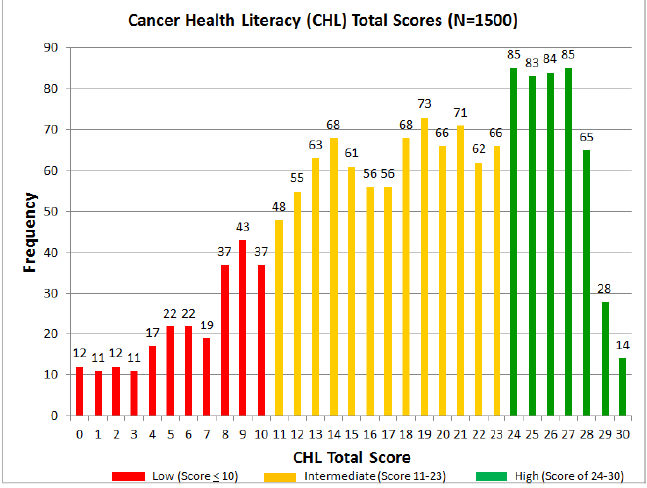
Figure 2. Cancer health literacy total scores.